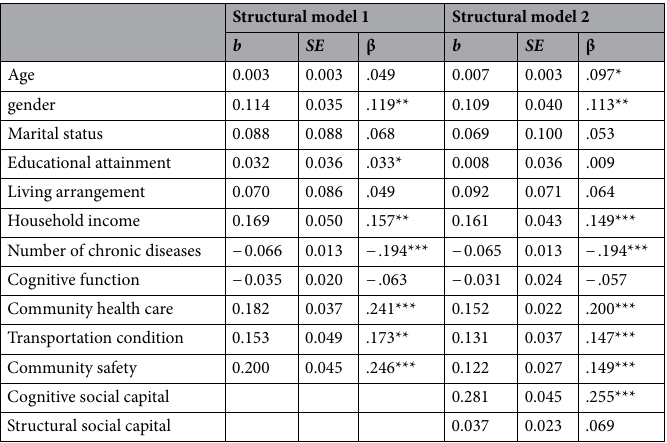
Table 2. Statistical models for life satisfaction among older adults. * p < .05; ** p < .01; *** p <